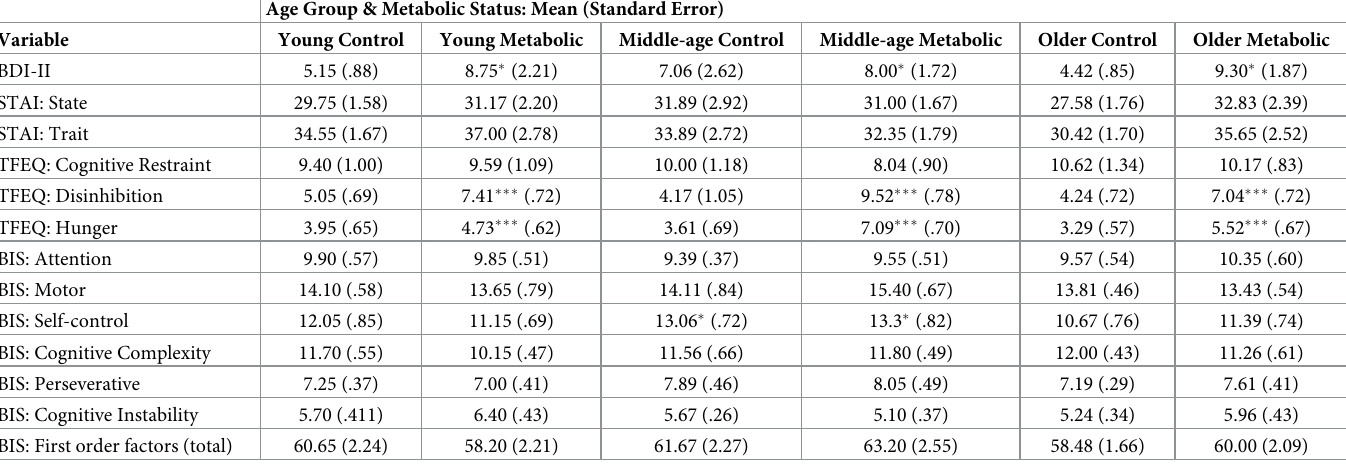
Table 2. Self-report measurements of participants. Age Group & Metabolic Status: Mean (Standard